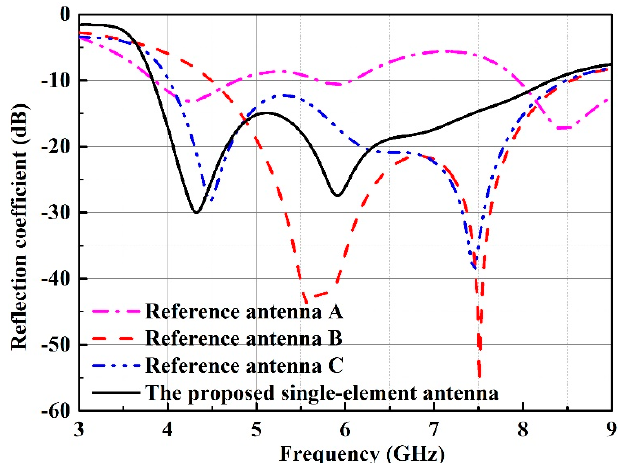
Figure 2. Simulated reflection coe ffi cients of reference antenna A, B, C and the proposed single-element antenna.